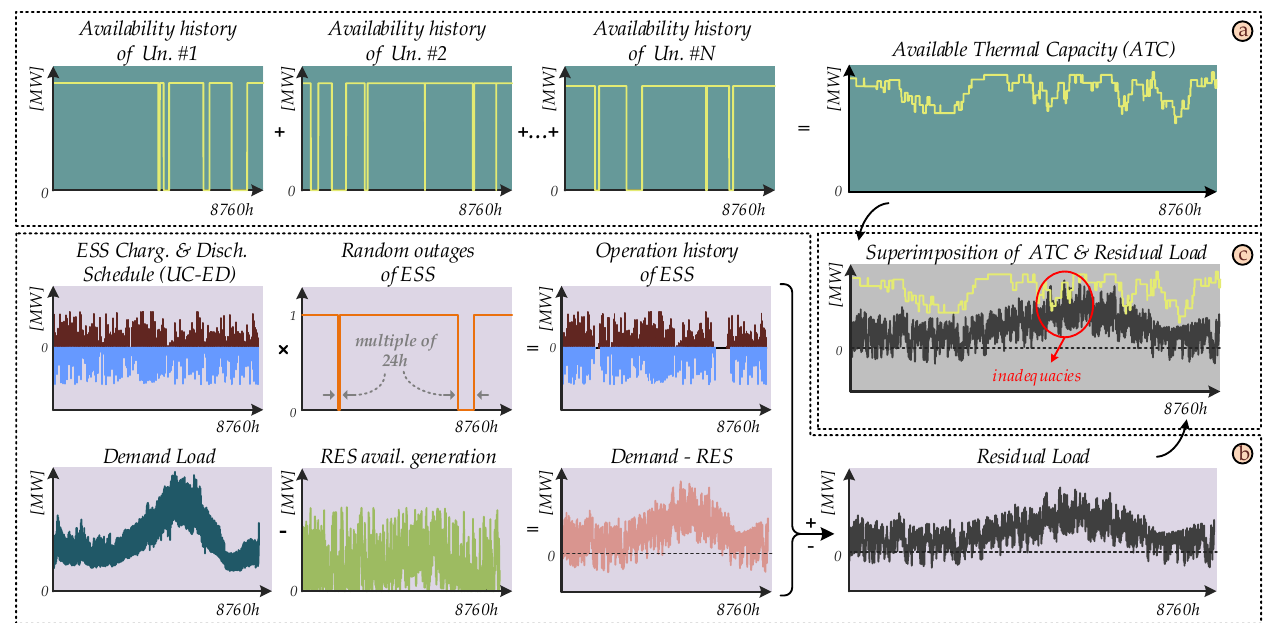
Figure 2. One sample year of the MCS process: ( a ) ATC modeling; ( b ) residual load modeling; ( c ) superimposition of ATC and residual load.